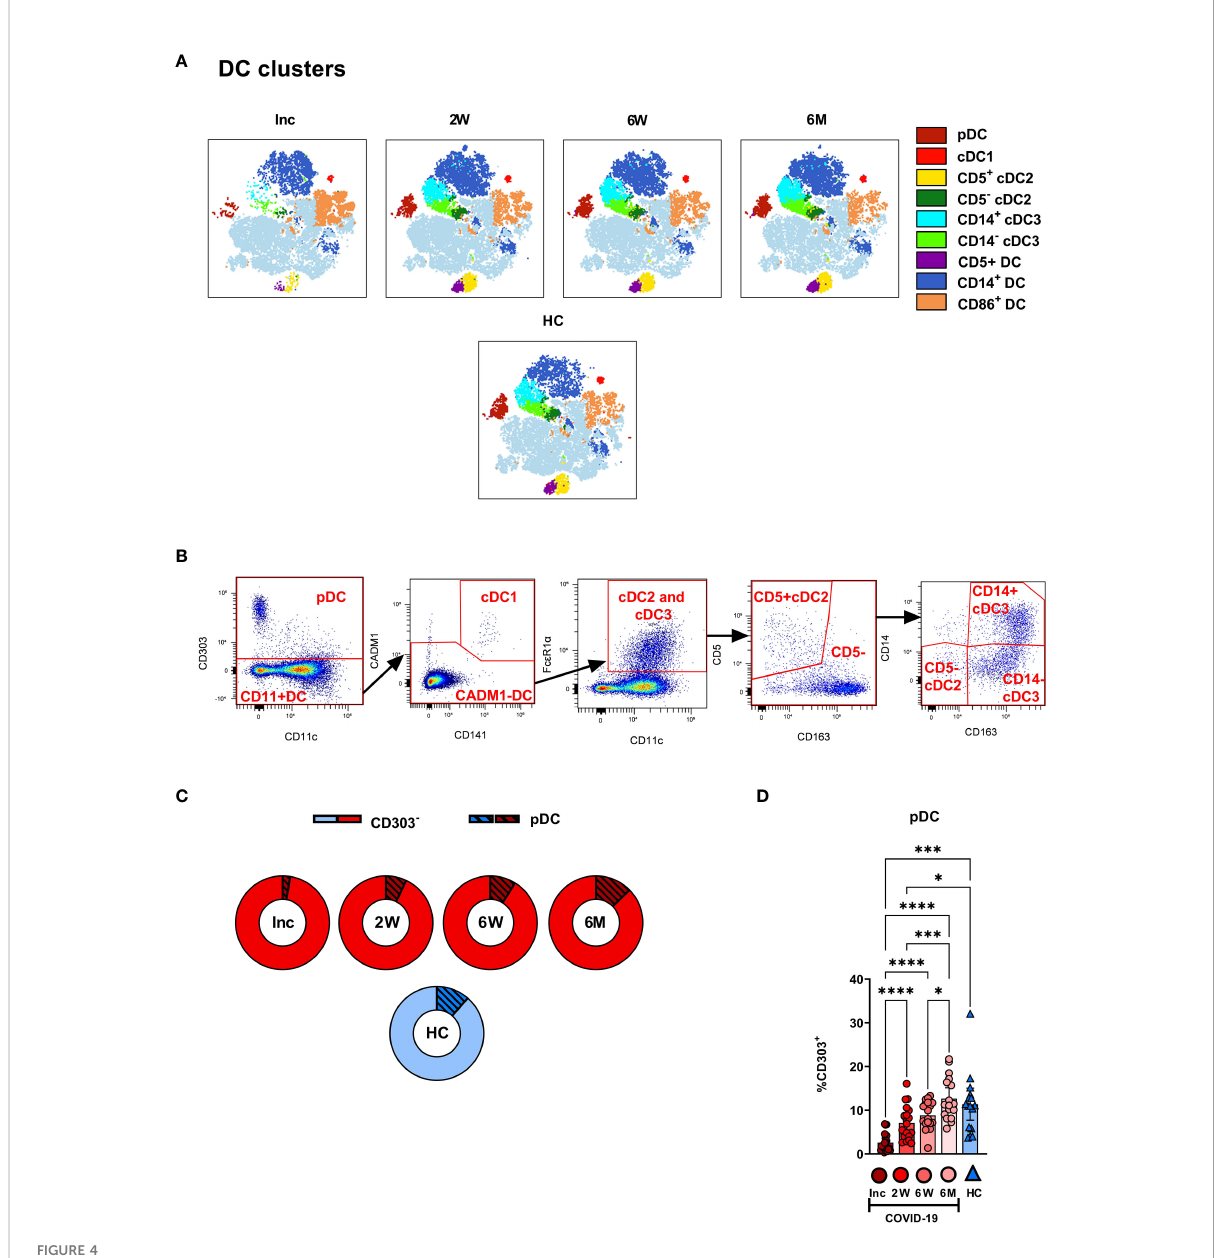
FIGURE 4 Plasmacytoid DCs in COVID-19 patients are severely depleted in blood during COVID-19. PBMCs collected from hospitalized COVID-19 patients (N = 21) and healthy controls (N = 16), were stained for fl ow cytometry to observe the effect of SARS-CoV-2 on the overall DC compartment. (A) tSNE plots illustrating the changing distribution of DC within CD88 - myeloid cells. (B) Gating strategy for DC subsets. (C) Ratio of CD303 - cells to pDC during COVID-19. (D) Percentages CD303 + pDC. Data are presented as mean with 95% Cl, with signi fi cance of *p ≤ 0.05, ***p ≤ 0.001, **** p ≤ 0.0001, determined using Brown-Forsythe and Welch ANOVA tests. Inc, Study inclusion; 2W, 2 weeks; 6W, 6 weeks; 6M, 6-7 months; HC, healthy